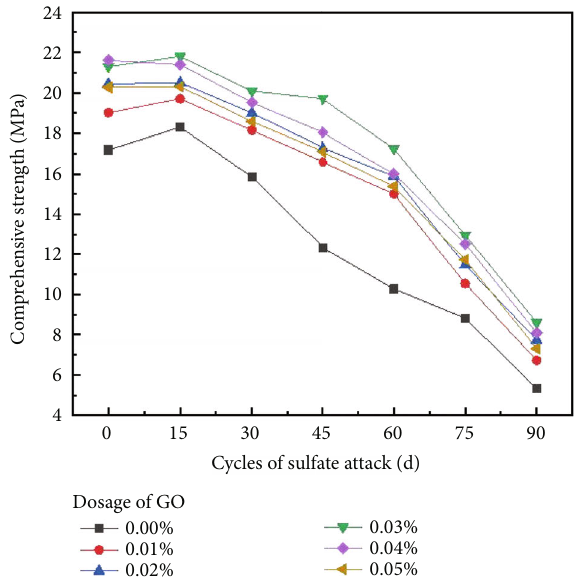
Figure 3: Quality changes of coral sand mortar.